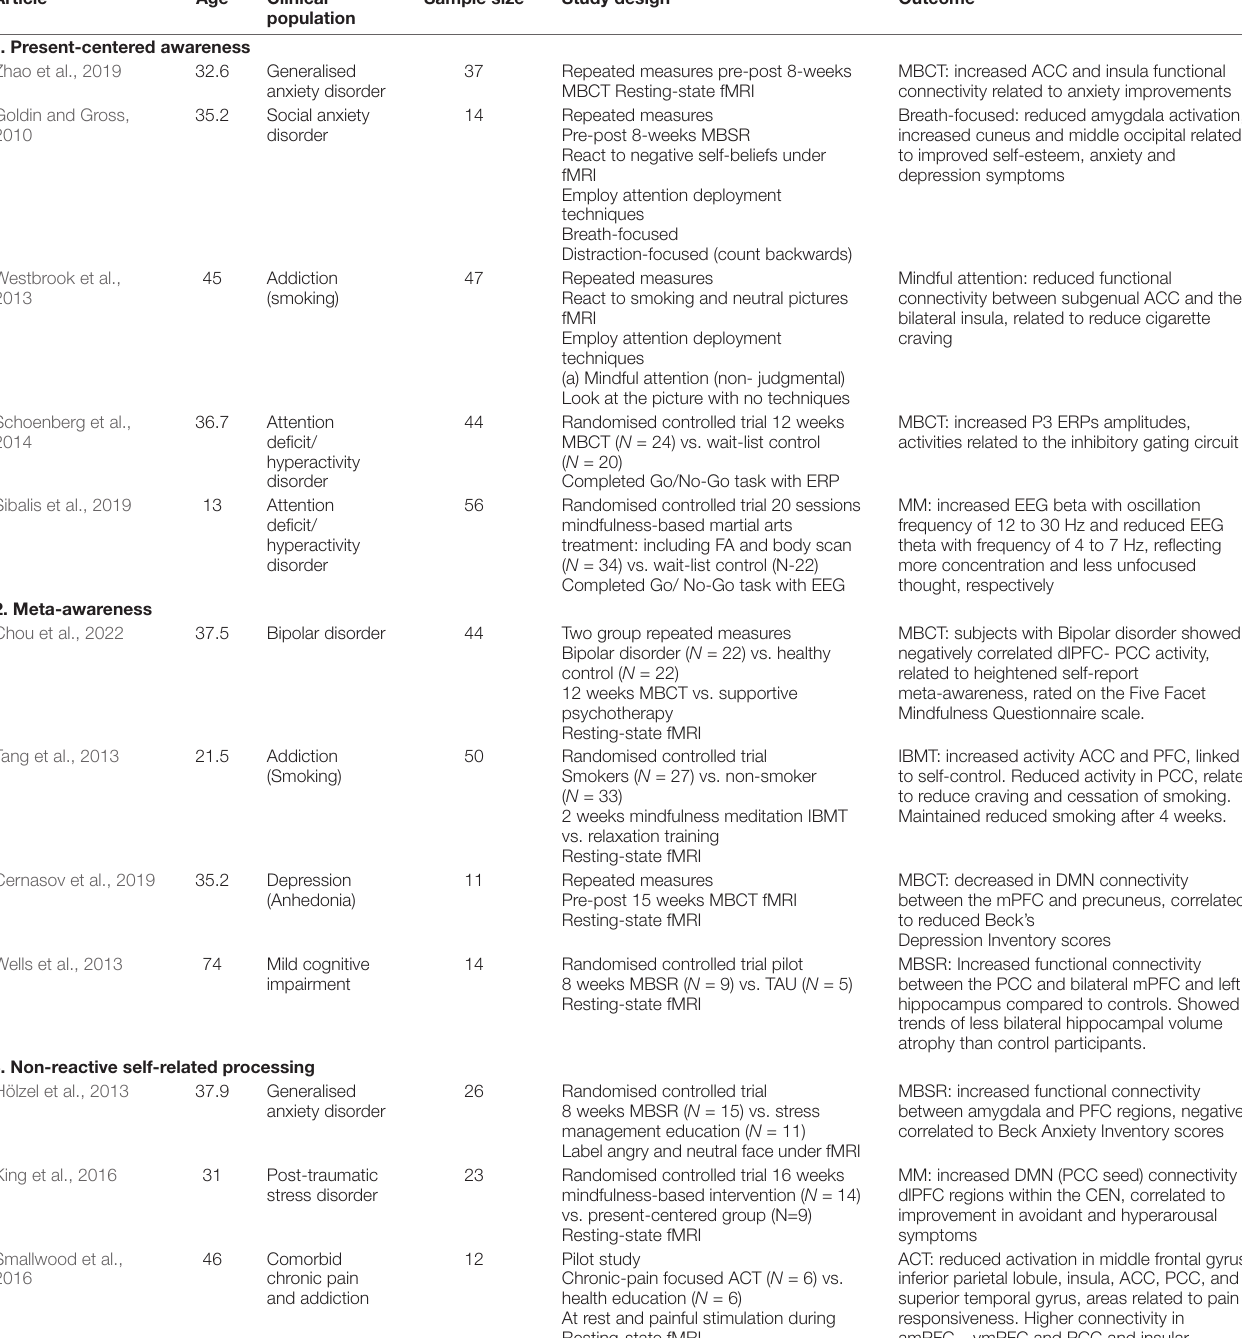
TABLE 2 | Neurological changes in the brain associated with mindfulness